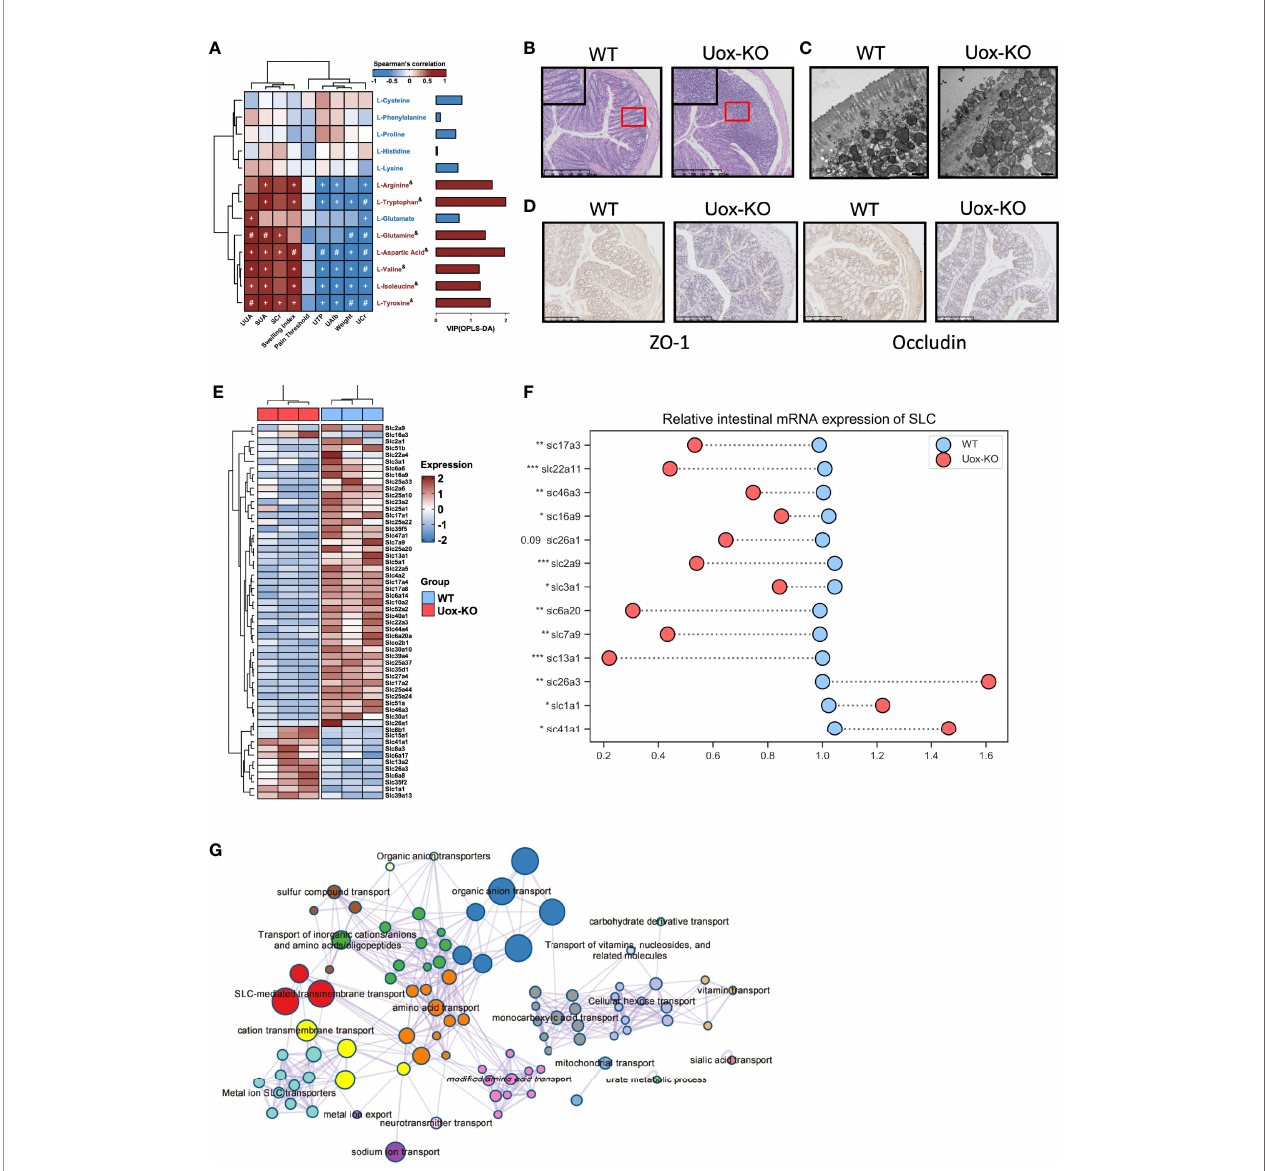
FIGURE 3 | Impaired intestinal mucosal barrier in Uox -KO mice. (A) Analysis of Spearman ’ s rank correlation between 13 feces amino acids and gout symptoms. Positive correlations are displayed in red and negative correlations in blue. The intensity of the color is proportional to the correlation coef fi cient. + p < 0.05; # p < 0.01; & on behalf of VIP>1. (B) H&E-stained of colonic sections (Scale bar: 250 µm). The boxed areas are shown enlarged. (C) Transmission electron micrograph of the intestinal villa in colon of WT and Uox -KO mice (Scale bar: 500 nm). (D) Expression of ZO-1 and Occludin in the colon was measured by immunohistochemistry (Scale bar: 250 µm). (E) Heatmap of 56 differentially expressed SLC genes in colon between WT and Uox -KO mice based on RNA transcriptome sequencing. (F) q RT-PCR validation of mRNA expression of randomly chosen SLC genes in mice intestinal tissues. (G) Network of enriched terms: colored by cluster ID, where nodes that share the same cluster ID are typically close to each other; colored by p -value, where terms containing more genes tend to have a more signi fi cant p - value. Values are expressed as mean ± SEM. * p < 0.05; ** p < 0.01; *** p <